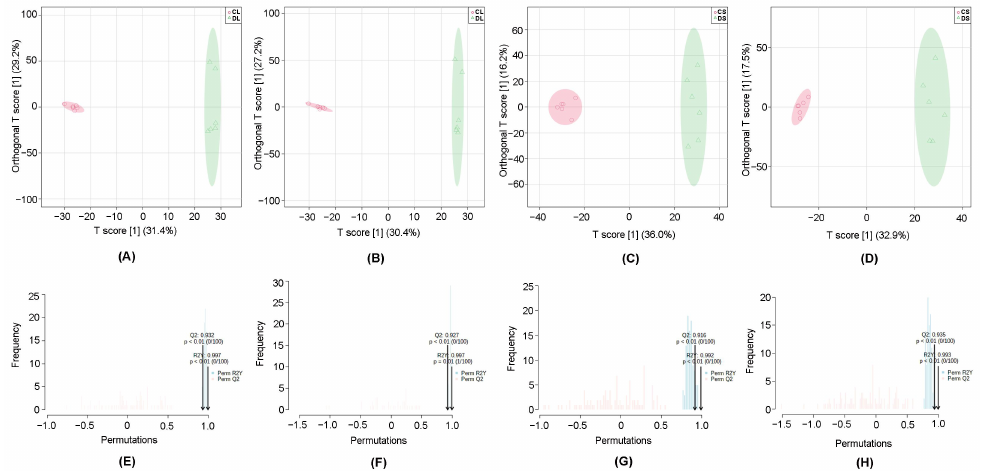
Figure 2. Orthogonal partial least squares discriminant analysis (OPLS-DA) score plot of metabolites in the control and diseased ginseng tissues. OPLS-DA score plot in CL and DL group in the negative ( A ) and positive ion mode ( B ); OPLS-DA score plot in CS and DS group in the negative ( C ) and positive ion mode ( D ). Permutation test with 100 permutations of the OPLS-DA model of ginseng leaves in the negative ( E ) and positive ion mode ( F ); Permutation test with 100 permutations of the OPLS-DA model of ginseng stems in the negative ( G ) and positive ion mode ( H ).